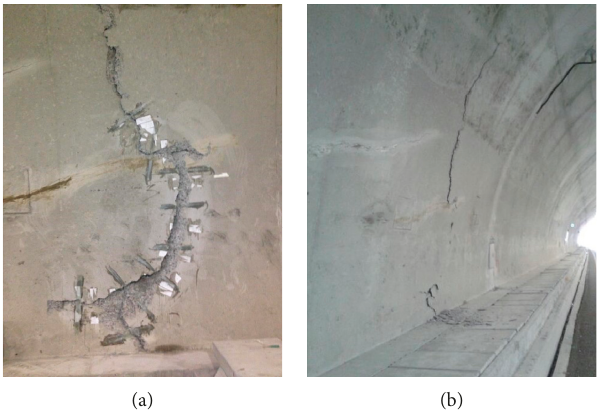
Figure 1: Crack of LK35 +168 (September 4